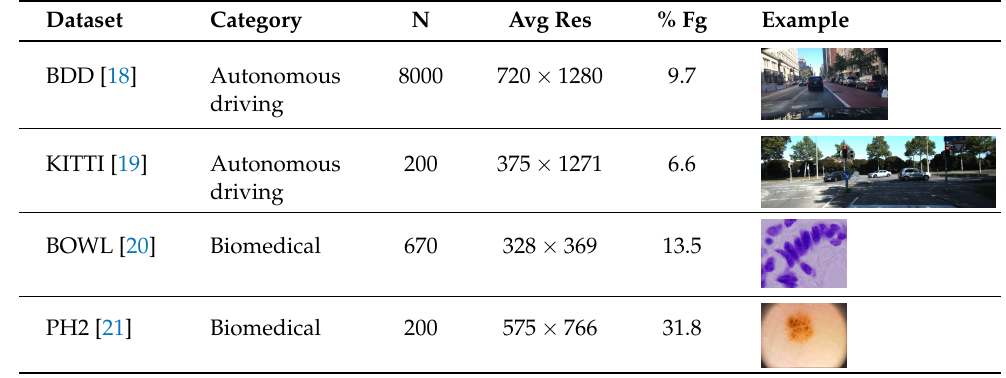
Figure 4. Pseudo-code of the proposed method.